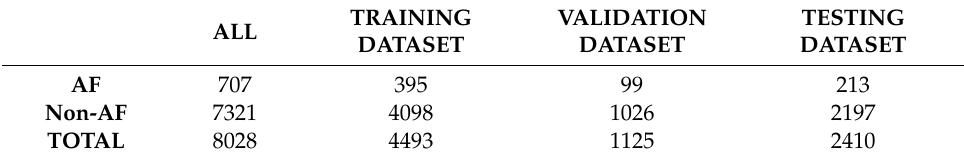
Table 2. Data division into training dataset, validation dataset and testing